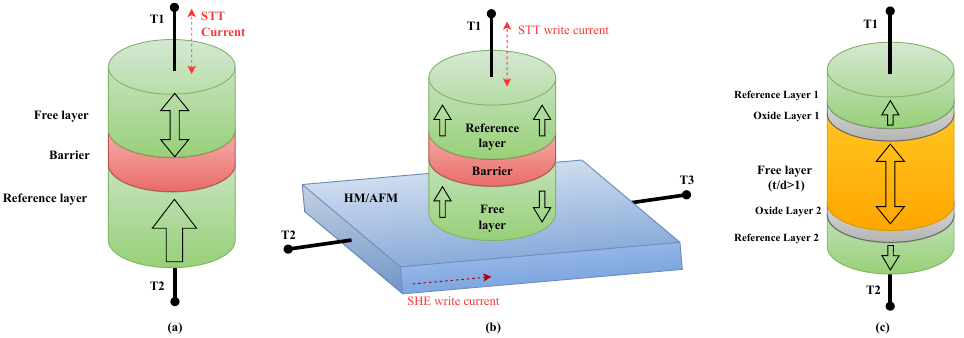
Figure 2. Typical structure of a ( a ) two-terminal conventional single barrier MTJ; ( b ) three-terminal MTJ; ( c ) s-PMA Double barrier